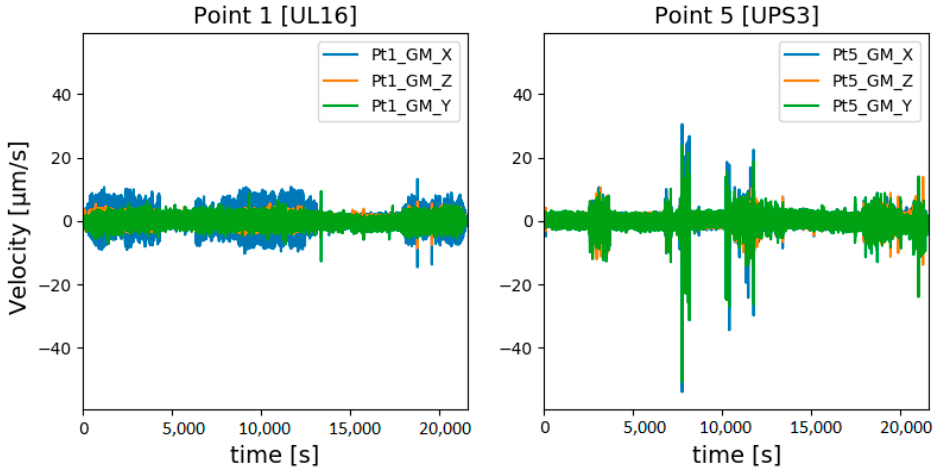
Figure 7. Seismic activity in LHC tunnel, 6 November 2019, 03:36 (UTC) + 360 min.